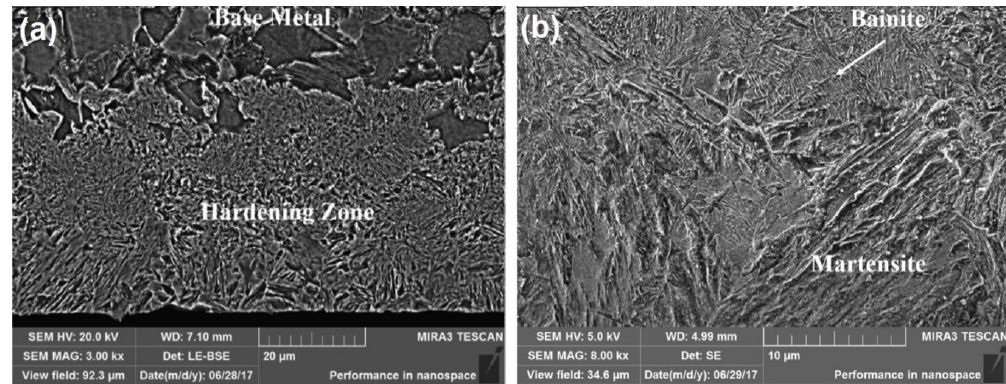
Figure 7. Cross-sectional SEM images of electron-beam-treated 30CrMnSiA steel ( a ) hardened zone; ( b ) higher magnification of the transition zone [28]. (Reproduced with permission from ref. [28]. Copyright (2017), Elsevier).